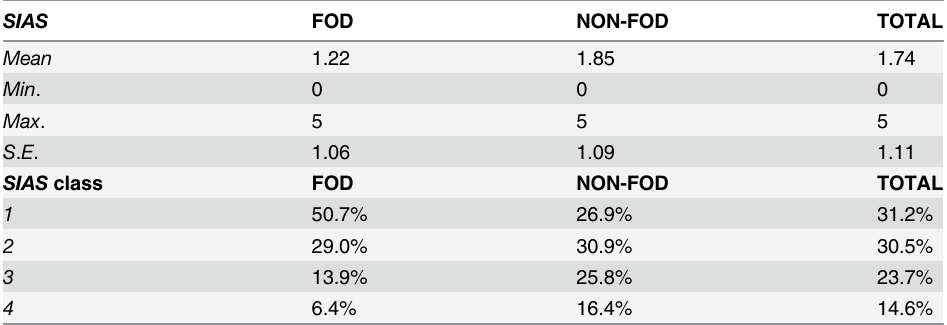
Table 2. Mean SIAS and distribution within SIAS classes according to gender and fatal overdose (FOD) status. SIAS FOD NON-FOD TOTAL Mean 1.22 1.85 1.74 Min . 0 0 0 Max . 5 5 5 S . E . 1.06 1.09 1.11 SIAS class FOD NON-FOD TOTAL 1 50.7% 26.9% 31.2% 2 29.0% 30.9% 30.5% 3 13.9% 25.8% 23.7% 4 6.4% 16.4% 14.6%